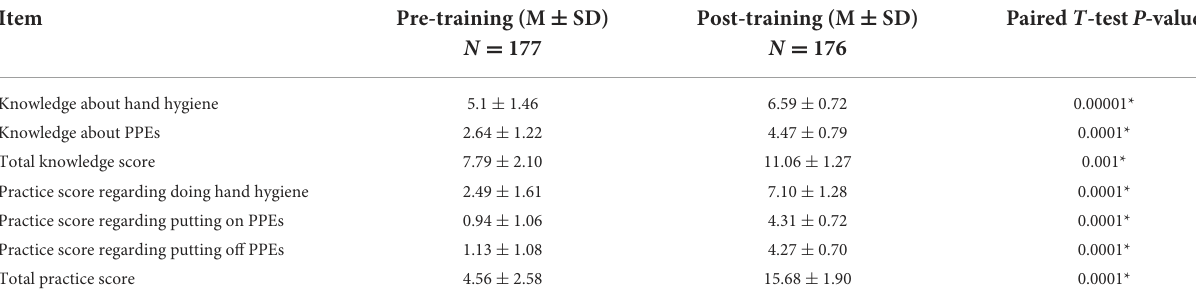
TABLE 4 Distribution of studied participants according to total knowledge and practices scores of infection control measures before and after